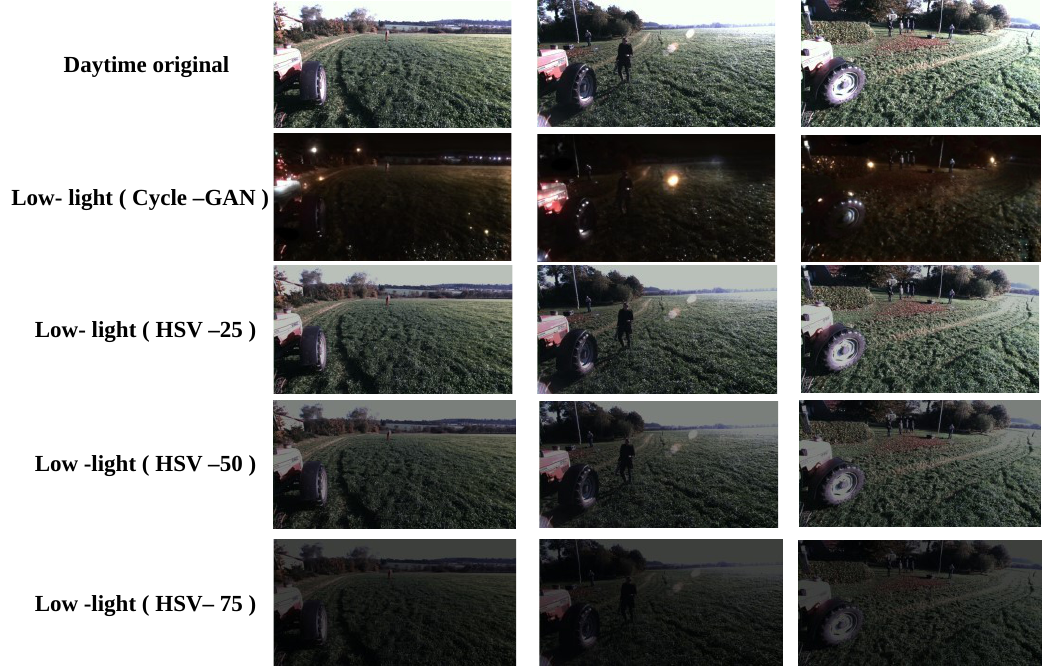
Figure 4. Generation of low-light images. From top to bottom are images in daytime, generated images by Cycle-GAN, generated images by reducing brightness of 25%, 50%, and 75%,